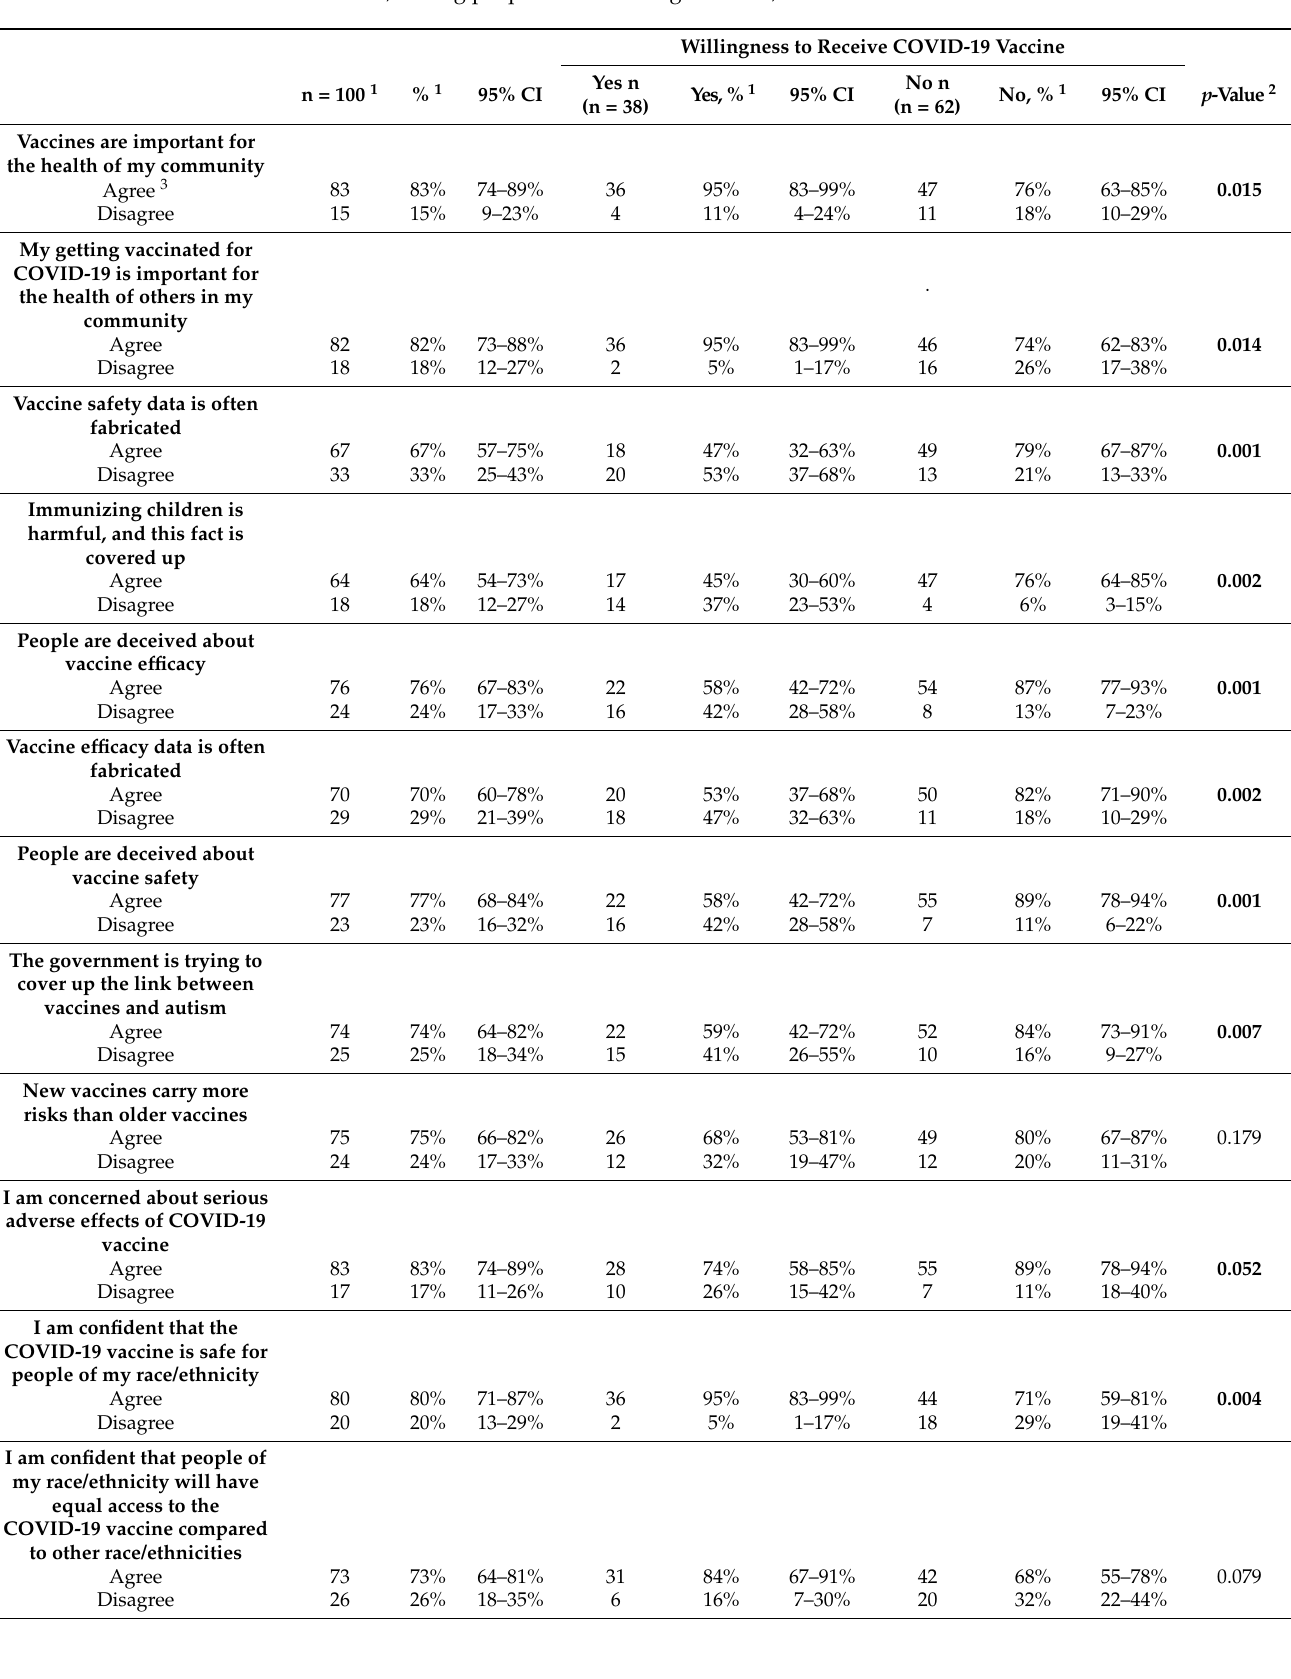
Table 3. Vaccine-related trust statements and associations with willingness to receive COVID-19 vaccine, among people who use drugs in NYC,